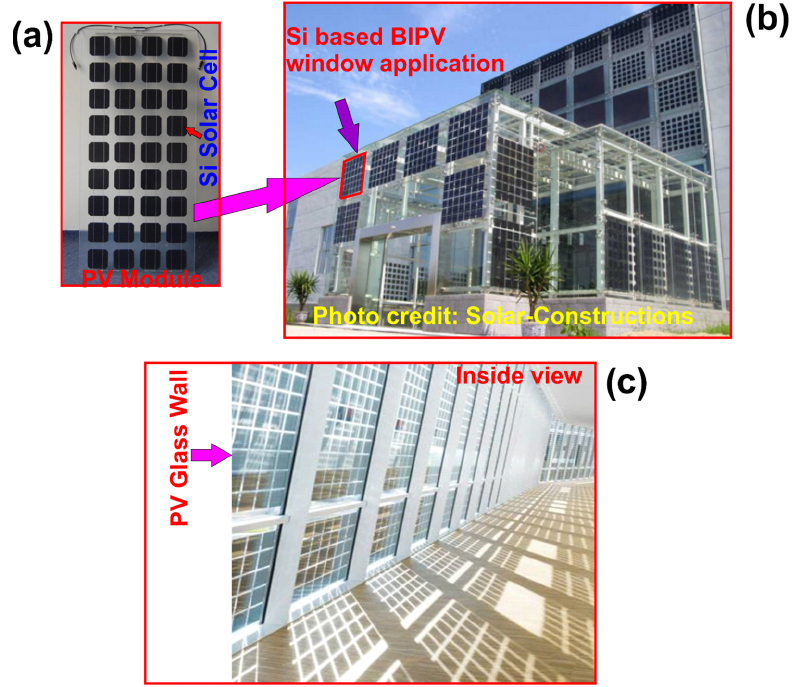
Figure 8. Crystalline silicon-based BIPV ( a ) Si module (reproduced and modi fi ed with permission from Ref. [80]); ( b ) application in building (reproduced and modified with permission from [80]) [80]; ( c ) inside views a tt ained with glass curtain wall (reproduced and modi fi ed from [81]).